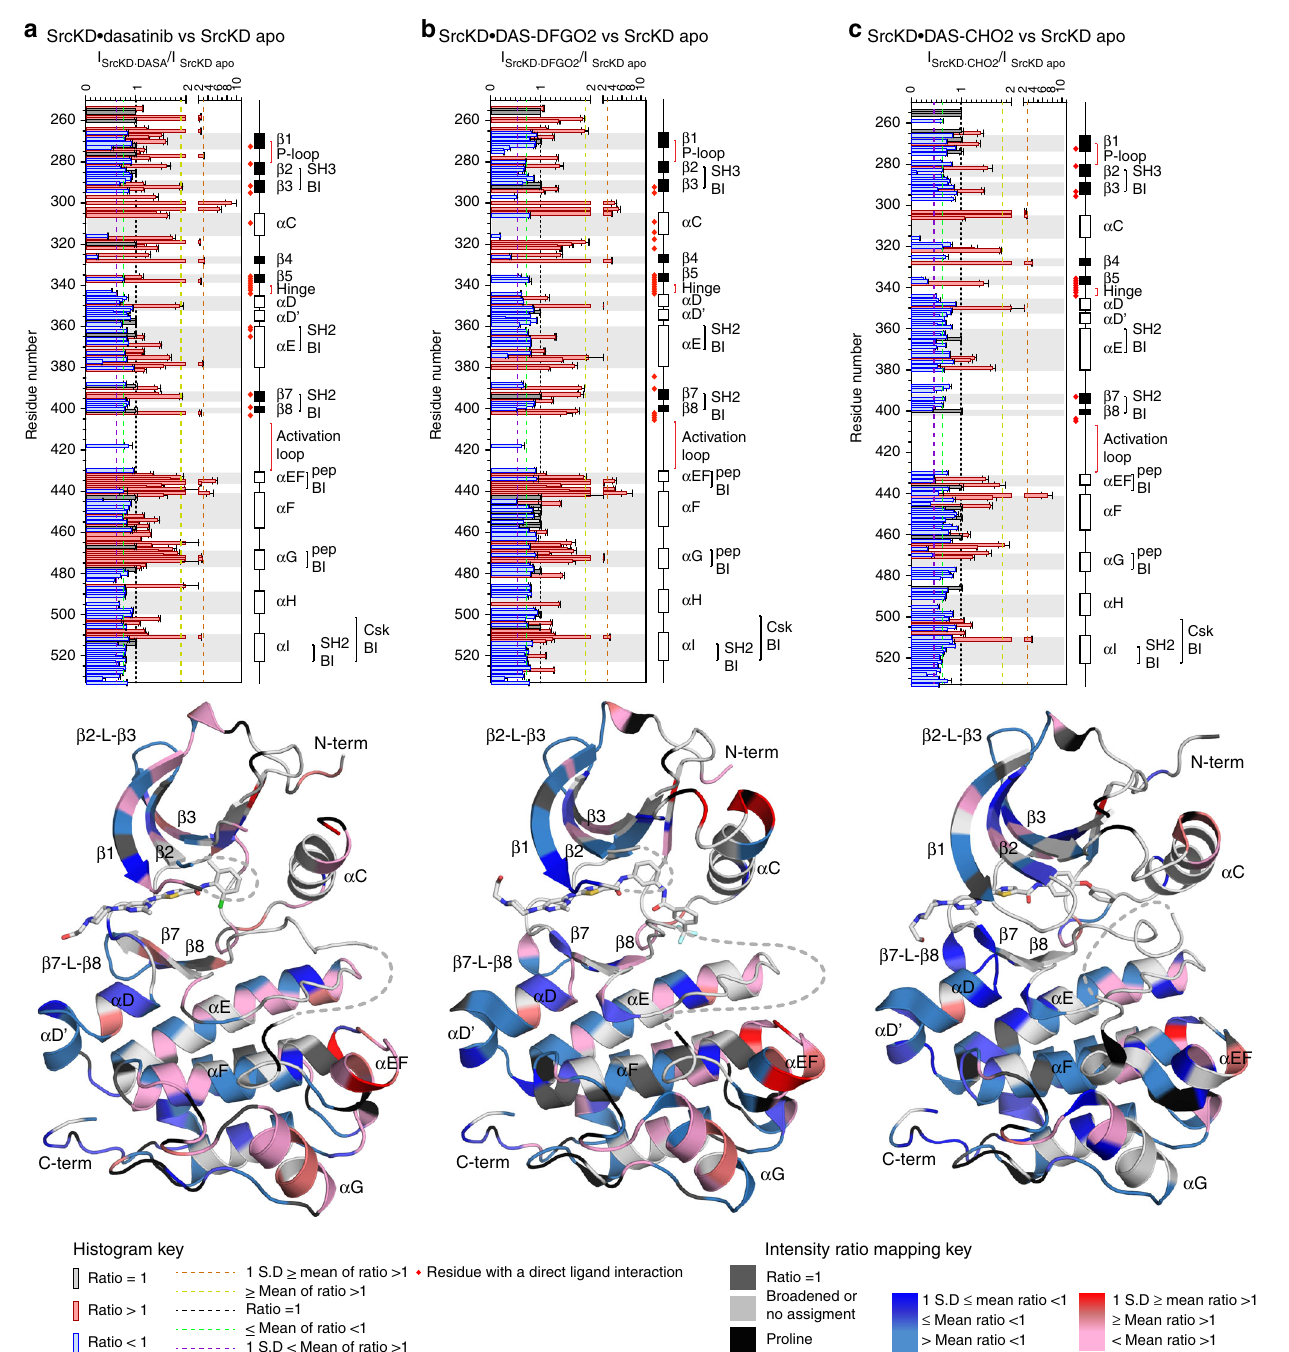
Fig. 4 Binding of conformation-selective ligands to apo SrcKD induces short and long-range dynamic changes. Backbone amide resonance intensity ratios of SrcKD ligand-bound states: a dasatinib, b DAS-DFGO2, c DAS-CHO2, relative to apo SrcKD were analyzed by histograms and by structure mapping (PDB-entry 3G5D, 4YBJ, 4YBK) 30,31 to infer dynamic changes. Intensity ratios > 1 (sharpening) suggest increased fast internal motions relative to conformational exchange, intensity ratios < 1 (broadening) suggest the opposite. Long-range sharpening occurs in the peptide binding interface upon dasatinib and DAS-DFGO2 binding but to a less extent for DAS-CHO2. In all states, broadening occurs in the SH3, SH2, Csk-binding interfaces but is most pronounced in the DAS-CHO2 bound state. Intensity ratios for the ligand-bound state to apo the state were determined only for resonances assigned and resolved in both states. IP error bars here and in subsequent IP fi gures are based on the S.D. of the noise level in the NMR (Supplementary Fig. 3; Supplementary Table 2). IPs with a ratio We therefore compared the intensity ratios of each ligand- smaller than 1 (broadened) suggest an increase in conformational stabilized conformational state to identify their dynamic differences exchange (slow internal motions) relative to fast internal motions, and similarities. We fi nd that dasatinib and DAS-DFGO2 cause whereas IPs with a ratio larger than 1 (sharpened) suggest the more sharpening than DAS-CHO2 (Fig. 4). Although some regions opposite. IPs with a ratio of 1 suggests no apparent change in sharpen with all ligands, the overall pattern and extent of resonance conformational exchange relative to fast internal motions. sharpening are similar between the dasatinib- and DAS-DFGO2-